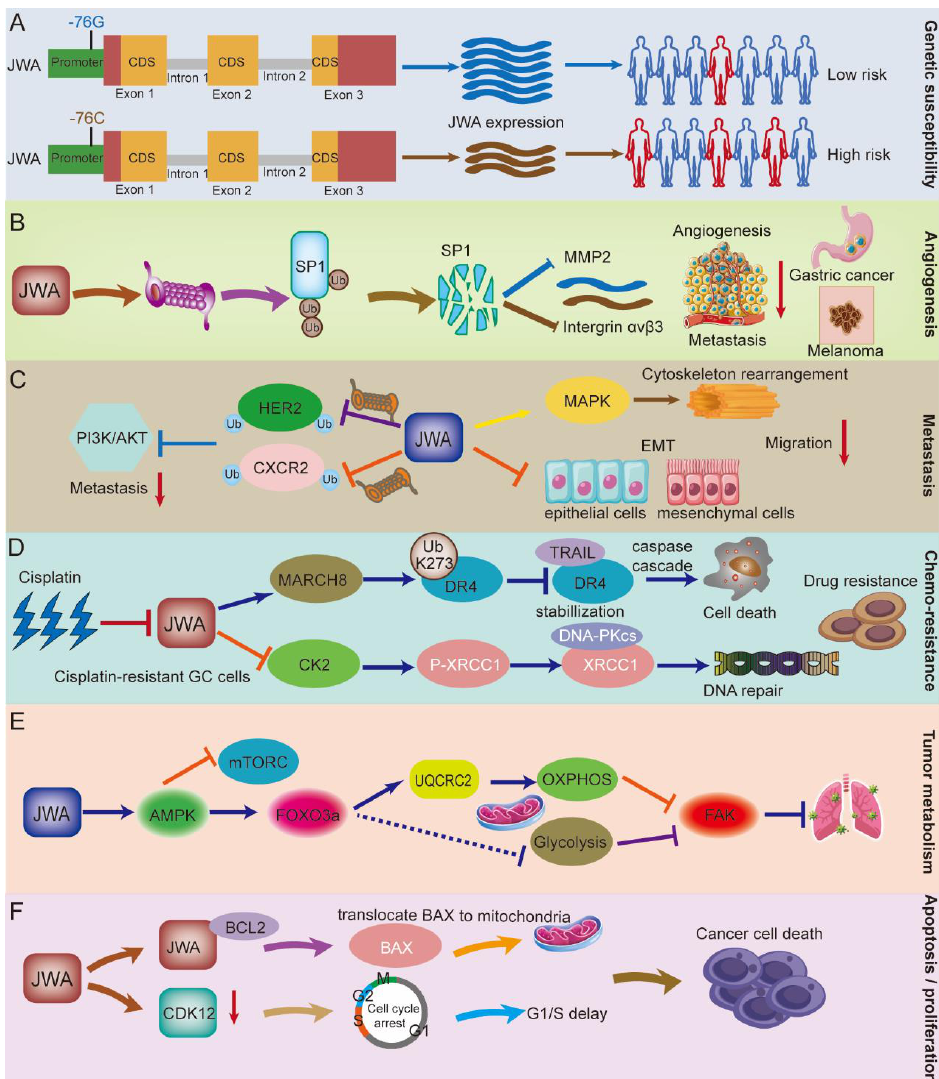
Figure 3. Molecular mechanisms of JWA in cancer. ( A ) Genetic susceptibility: JWA can act as a